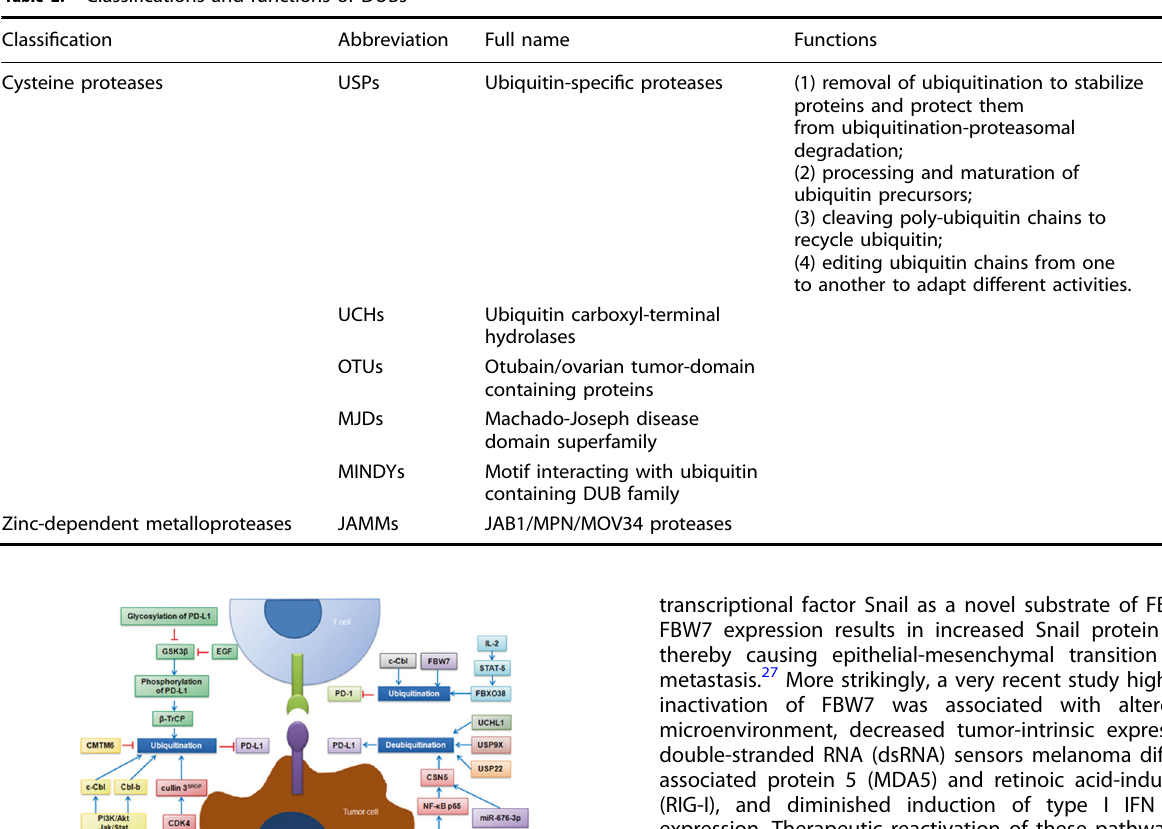
Table 2. Classi fi cations and functions of DUBs